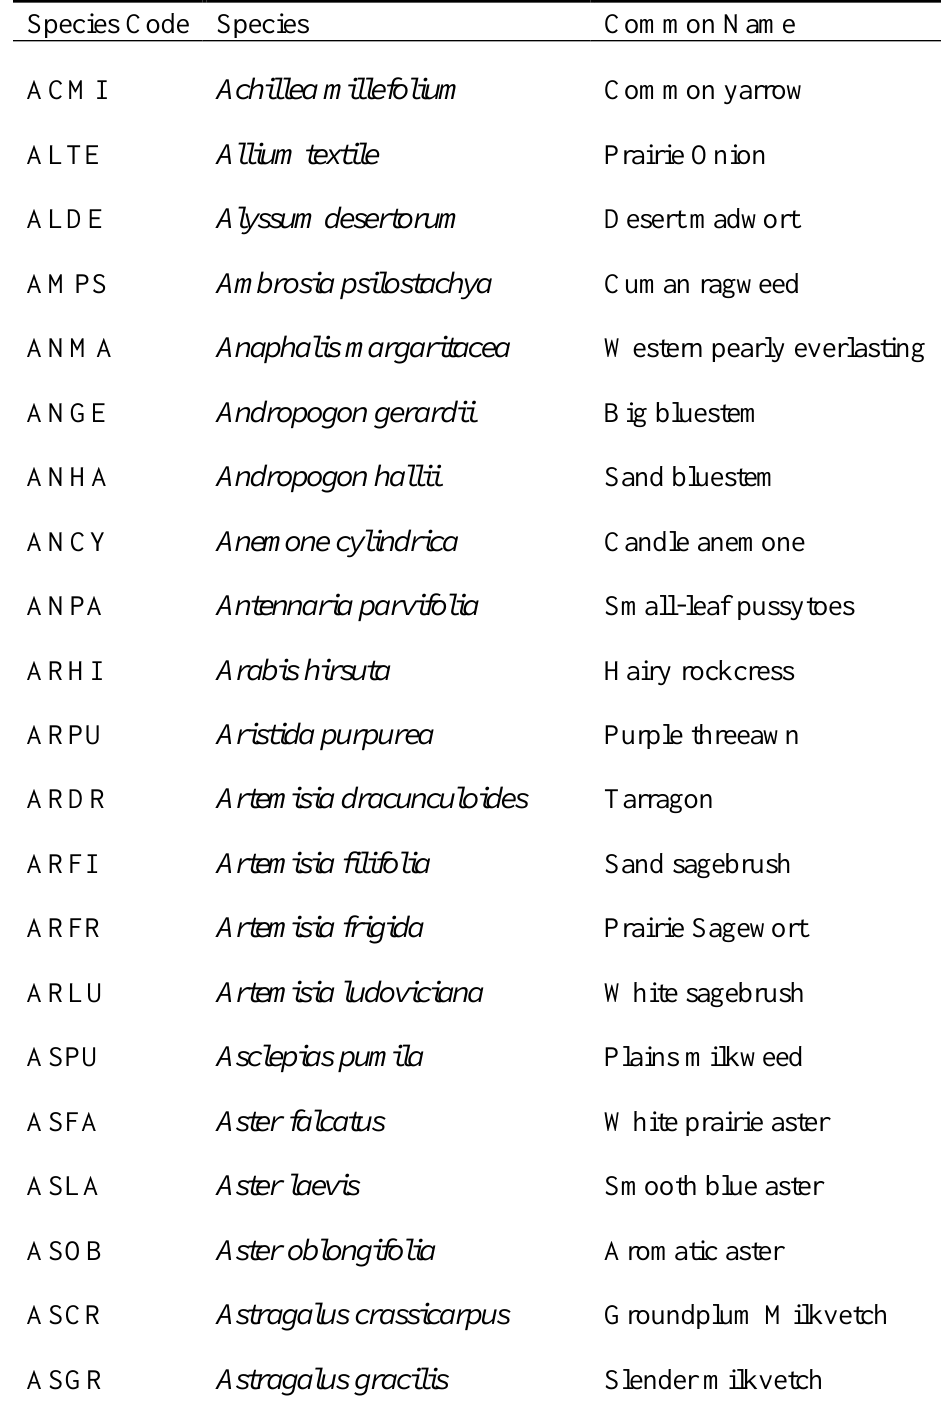
Table A1.3. A list of species codes, species names, and common names of herbaceous vegetation that was recorded within and surrounding the perimeter of the 1989 Fort Robinson wildfire, Nebraska,